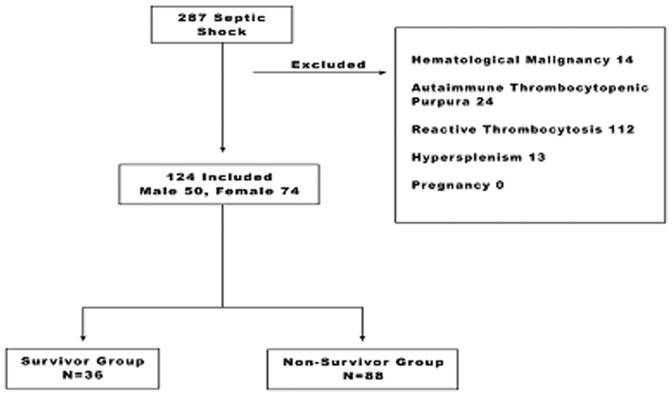
Flowchart of the enrollment of septic shock patients.